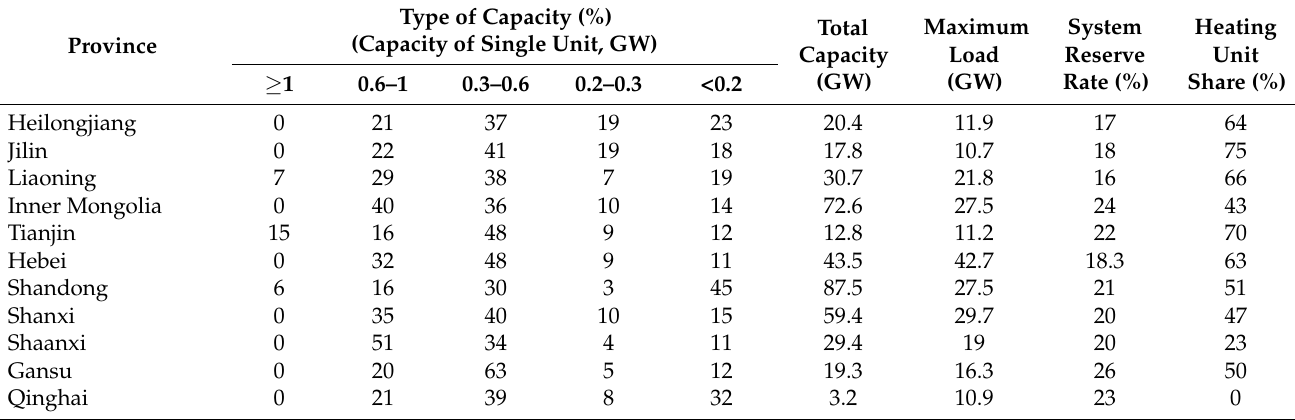
Table A2. Structural capacity data of thermal power and maximum load of provincial power system,